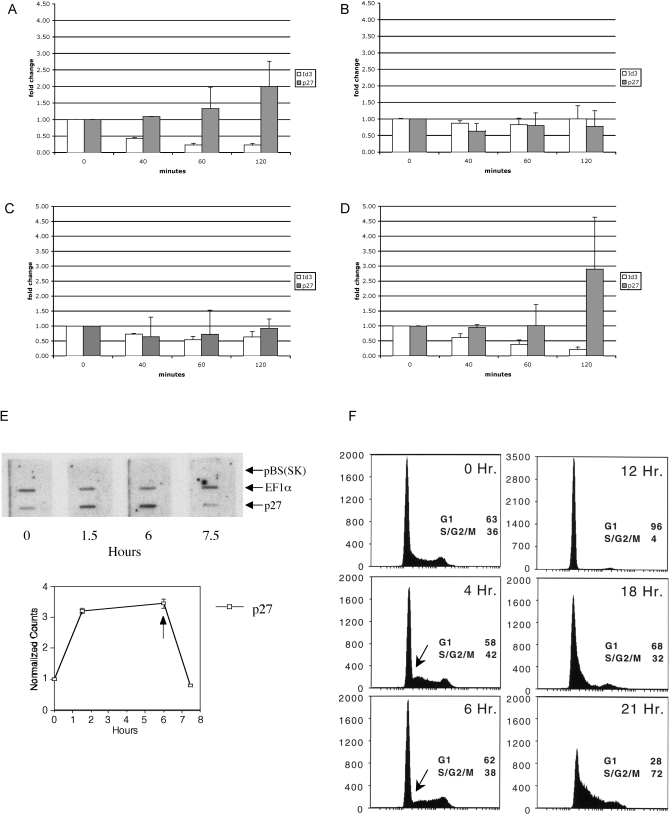
p56Lck Regulates p27 Gene Expression Via Id3 in Lymphoma CellsQuantitative RT-PCR detected transcript levels for Id3 and p27 in PP1 inhibited (A) Lck-expressing cells LGY-6871, (B) SV40–180 large T-protein transformed cells, (C) LGY-6871 cells infected with an Id3 retrovirus, and (D) LGY-6871 cells infected with the control retrovirus are shown in the graph. PP1 was added immediately after the time-0 timepoint was collected, and later aliquots were collected at the specified times. The Id3 probe and primers detect endogenous and retroviral expressed Id3. HPRT1 gene expression was used to normalize each sample. The fold change in transcript levels is relative to the 0 timepoint.(E) Representative autoradiograph of nuclear run-on assays from PP1 inhibited Lck-expressing cells LGY-10442–2 is shown and quantitative data from three experiments. The p27 transcript levels were normalized to EF1α transcript levels. PP1 was added to the culture after the 0 timepoint and washed out after 6 h as indicated by the arrow.(F) FACS analysis of PP1-inhibited Lck-transformed lymphoma cells LGY-10442–2. The cells were treated as described for (E). The arrow indicates depletion of early S-phase cellsdoi:10.1371/journal.pgen.0030219.g004